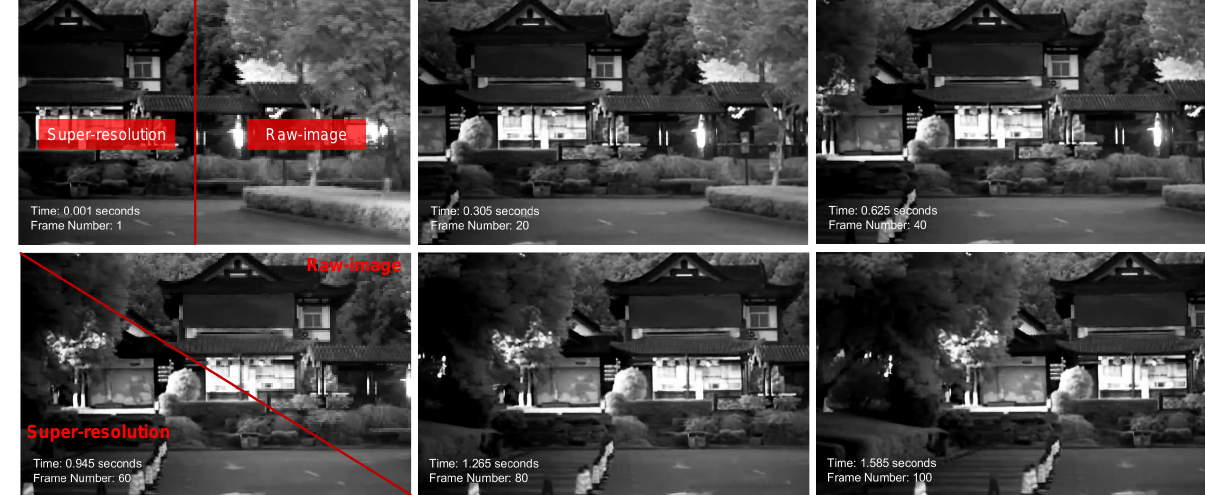
Figure 7. The output part of the real-time image in the video